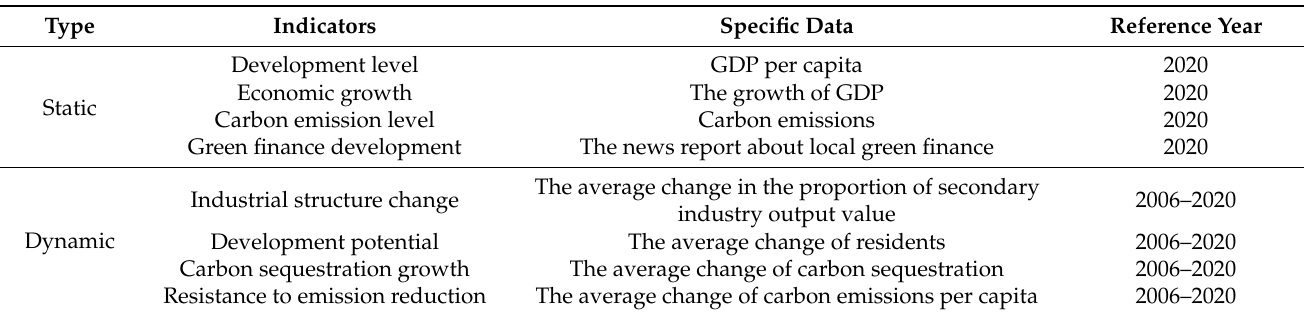
Table 5. Clustering